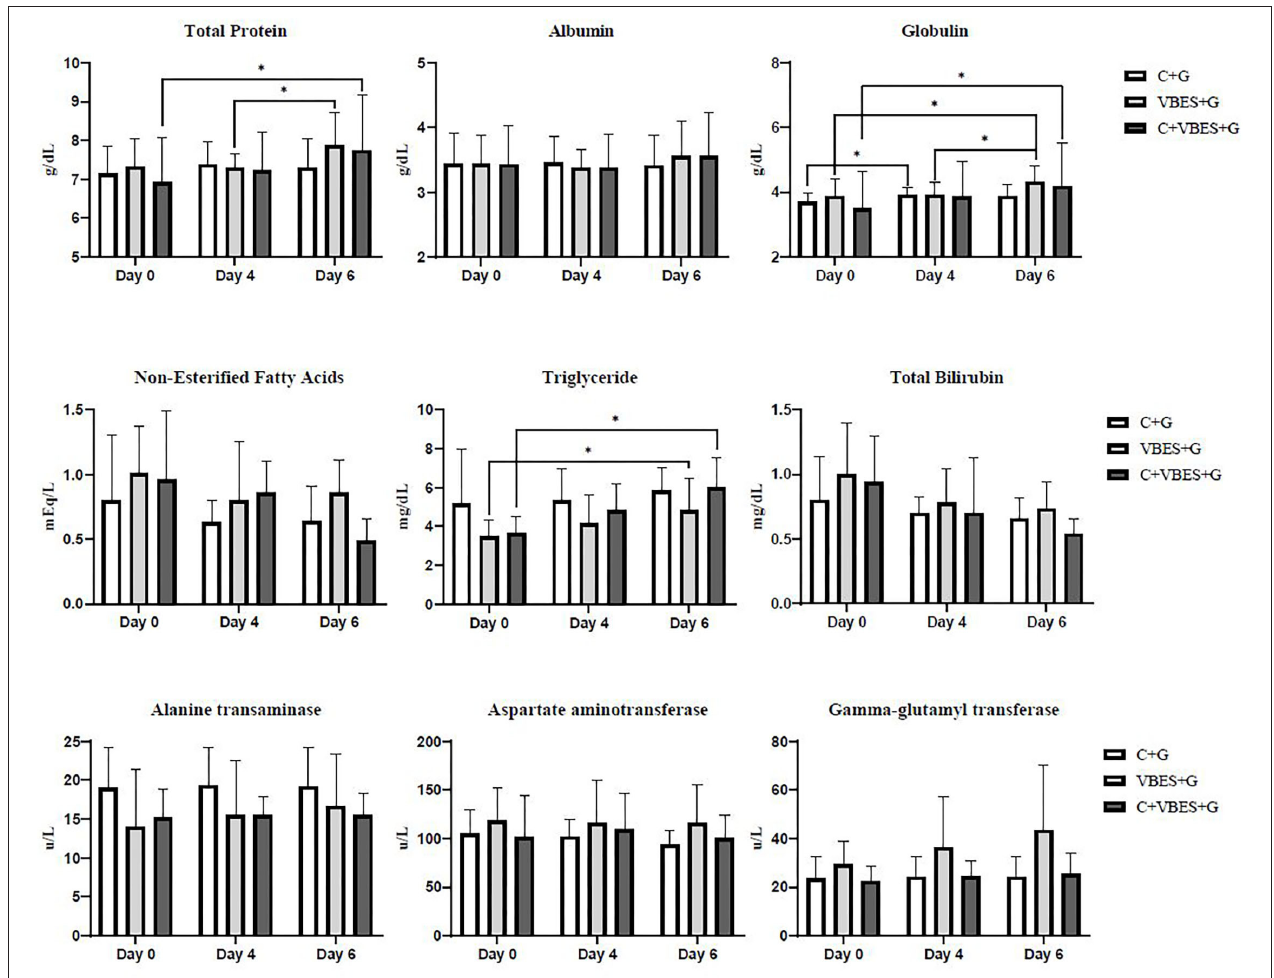
FIGURE 4 | Total protein, albumin, globulin, non-esterified fatty acids, triglyceride, total bilirubin, alanine transaminase, aspartate aminotransferase, and gamma-glutamyl transferase on the pre-treatment day (Day 0), and on 1 day (Day 4) and 3 days (Day 6) after the last treatment day. C + G = levocarnitine and glycerin, VBES + G = vitamin B complex, vitamin E with selenium, and glycerin, C + VBES + G = levocarnitine, vitamin B complex, vitamin E with selenium, and glycerin. Data are presented as the mean ± standard deviation. * p < 0.05. β -hydroxybutyrate dehydrogenase to degrade ketone bodies